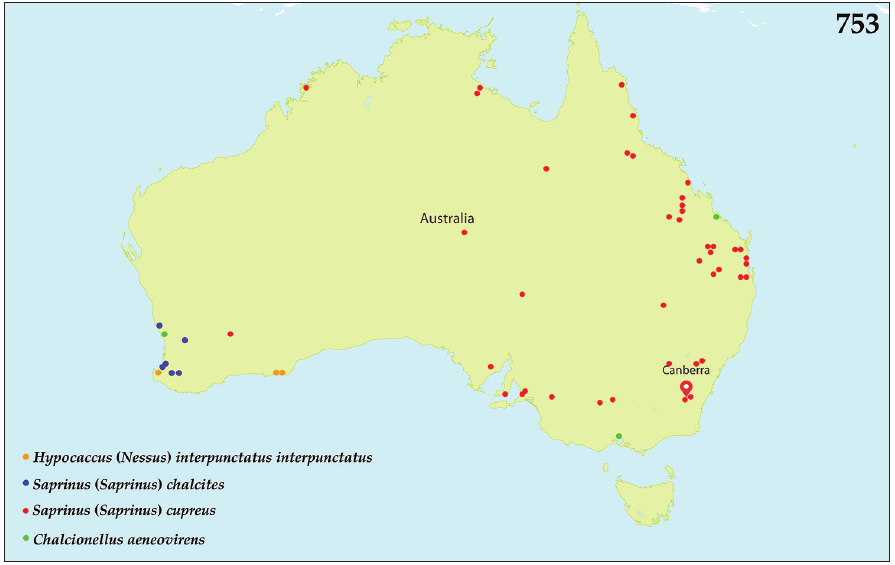
Figure 753. Distribution of four introduced Saprininae in Australia: Chalcionellus aeneovirens (Schmidt, 1890); Hypocaccus ( Nessus ) interpunctatus interpunctatus (Schmidt, 1885); Saprinus ( Saprinus ) cupreus Er- ichson, 1834 and Saprinus ( Saprinus ) chalcites (Illiger, 1807).